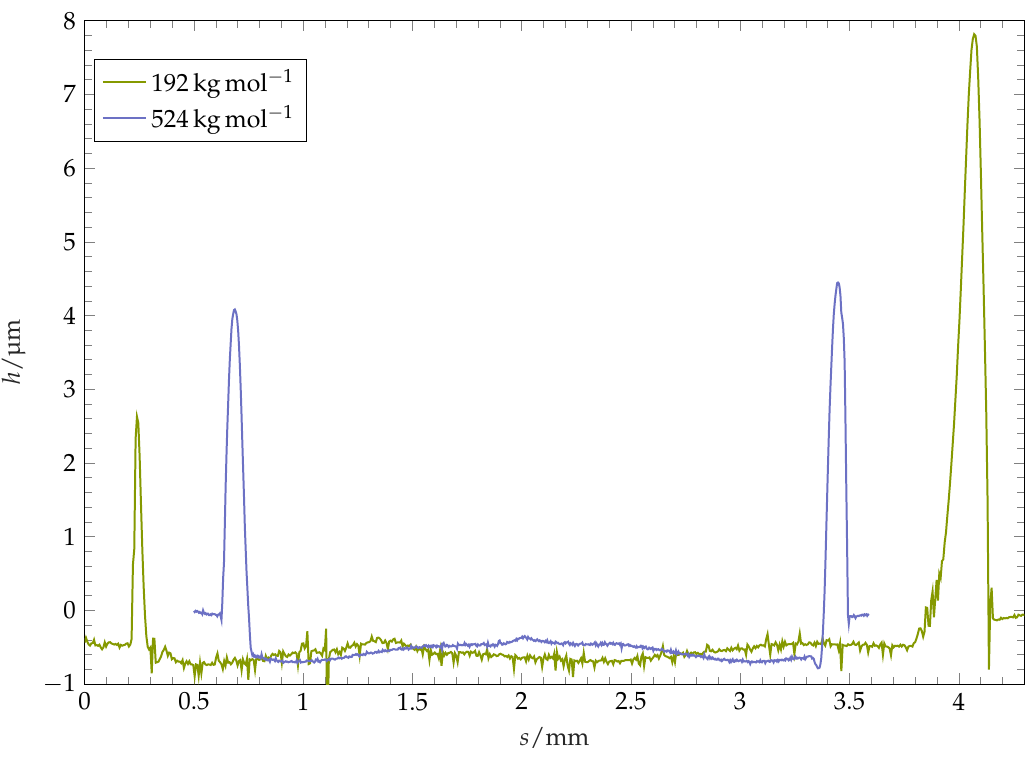
Figure 9. Coatings height profile along diameter after solvent evaporation for different coating molar masses. The non-symmetry for M W = 192kgmol − 1 stems from perturbations along the ridge line as presented in Figures 8 and 12. Profiles are magnified in height.